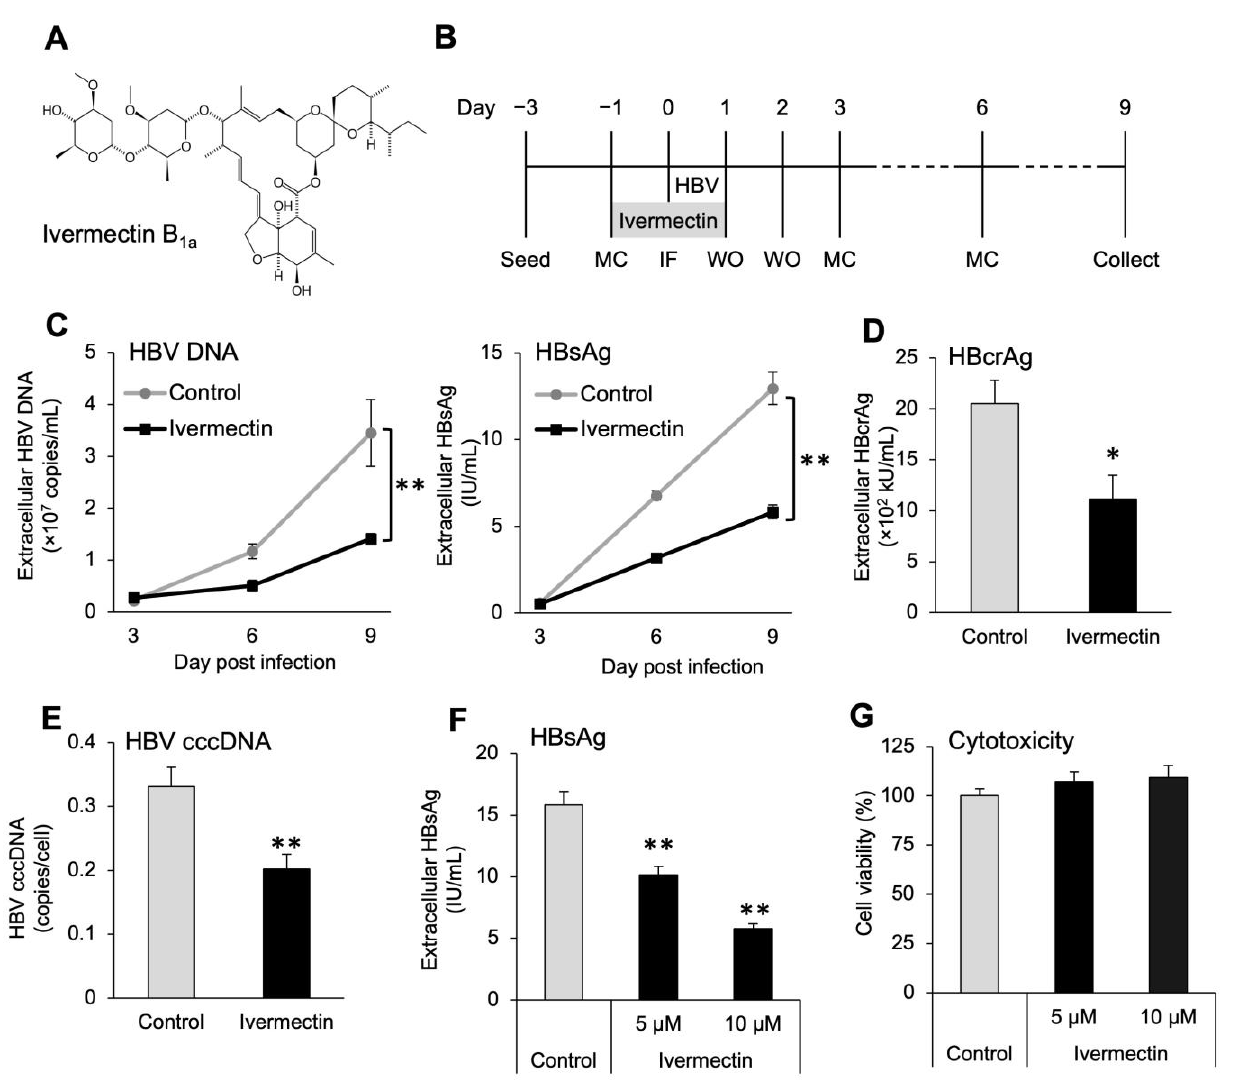
Figure 1. Ivermectin inhibited HBV infection in HepG2-hNTCP-C4 cells. ( A ) Chemical structure of ivermectin. ( B ) Experimental scheme for HBV infection in HepG2-hNTCP-C4 cells. HepG2-hNTCP- C4 cells were treated with 5 µM ( F , G ) or 10 μM ( C – G ) ivermectin for 48 h . MC, medium change;